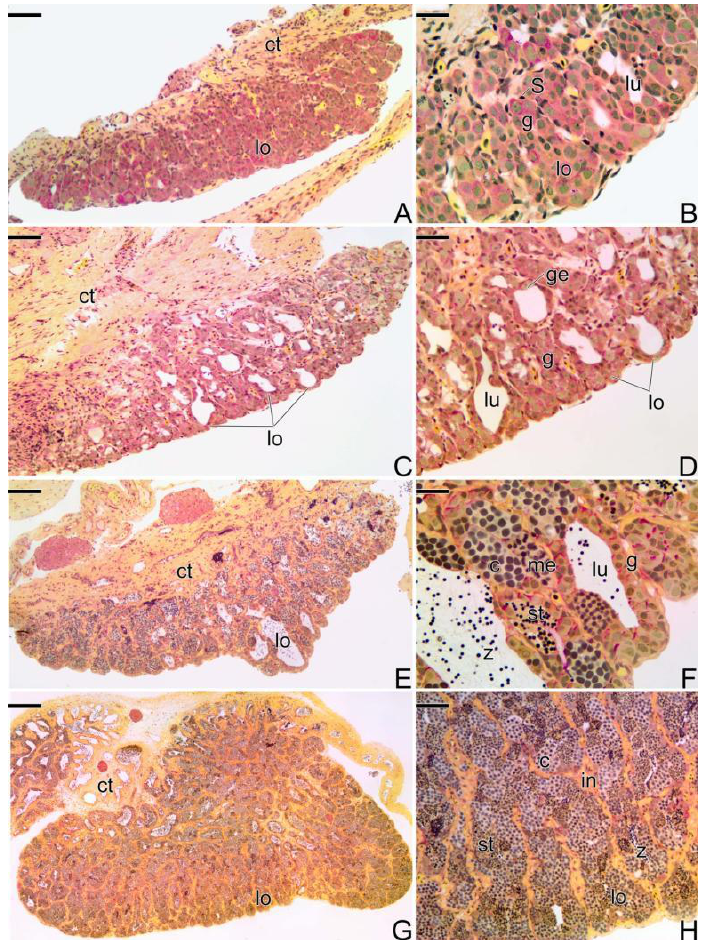
Figure 7. Histological sections of testes of primary males of S. marmoratus . Note the development of the testicular lobules, according to the progress of hte spermatogenesis. ( A , B ) Early testicular development. Germinal epithelium ir formed by Sertoli cells and spermatogonia. ( C , D ) Testicular lobules expand, increasing the testicular lumen. ( E , F ) Beginning of the spermatogenesis. ( G , H ) Testicular lobules are filled by spermatozoa. Connective tissue (ct), testicular lobules (lo), spermatogonia (g), Sertoli cell (S), testicular lumen (lu), germinal epithelium (ge), spermatocytes (c), metaphase (me), spermatids (st), spermatozoa (z). Staining: MY. Bar: 100µm ( A , C , E ), 20µm ( B , D , F ), 200µm ( G ), 50µm ( H ).